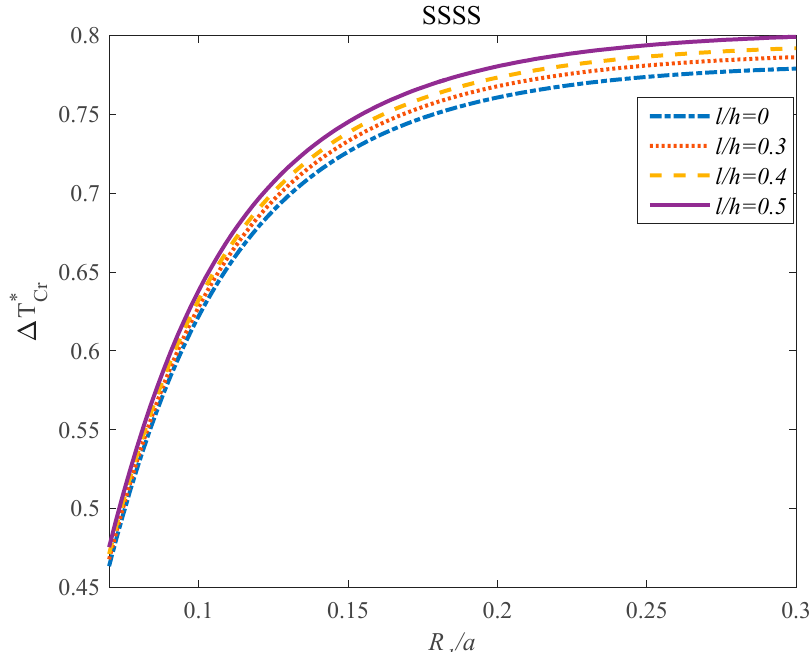
Figure 13. The effects of l/h and 𝑅 (cid:2869) /𝑎 parameters on the critical temperature of the GPLRC panel Figure 13. The e ff ects of l / h and R 1 / a parameters on the critical temperature of the GPLRC panel subjected to SSSS boundary conditions (b/a = 4, h = a/10, R2 = 5b, N L = 10, 𝜇 (cid:3404) ℎ/10 , 𝑔 (cid:3008)(cid:3017)(cid:3013) = 1%, and subjected to SSSS boundary conditions (b / a = 4, h = a / 10, R2 = 5b, N L = 10, µ = h /10, g GPL = 1%, Appl. Sci. 2020 , 10 , x FOR PEER REVIEW GPL ‐ O). and GPL-O).